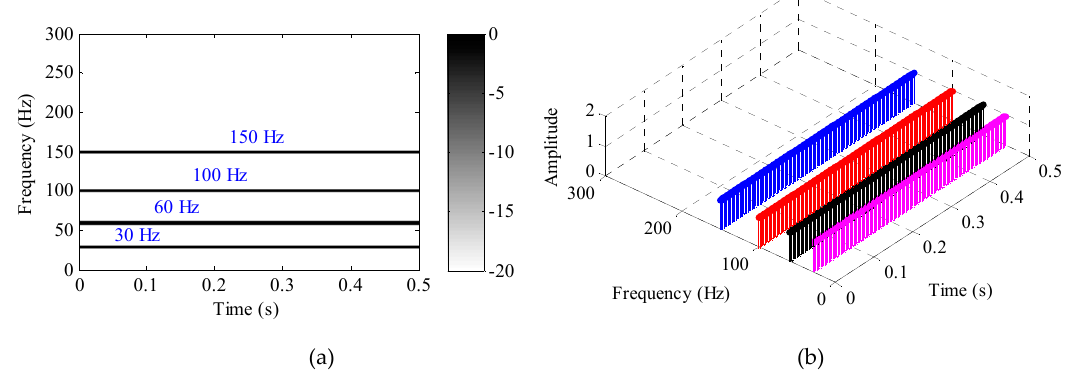
Figure 10. The time-frequency representations obtained by IAVMD for simulation 1: ( a ) Two-dimensional